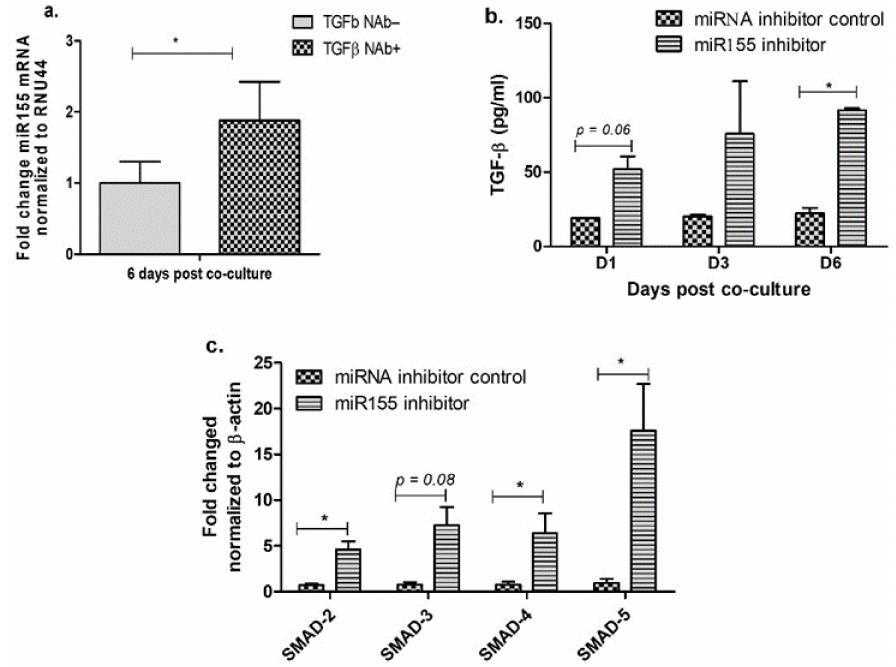
Figure 2. Inhibition of miR-155 increases TGF- β signaling in the cervical epithelial cells. Assessing miR-155 gene expression in the HIV infected ME-180 cells in the presence and absence of TGF- β NAb ( a ). ME-180 cells were transfected with miR-155 inhibitor or scrambled miR inhibitor (mock) 24 h prior to co-culture with the infected T cells and at indicated time intervals, cells and supernatant were collected. Supernatant was used for the quantitation of TGF- β protein by ELISA ( b ); and cells were used to determine the gene expression of SMAD-2, SMAD-3, SMAD-4, and SMAD-5 using real- time PCR. Fold change mRNA expression was calculated over mock transfected cells ( c ). Statistical analysis was performed by unpaired Student’s t -test to determine the level of significance. * indicates p value <